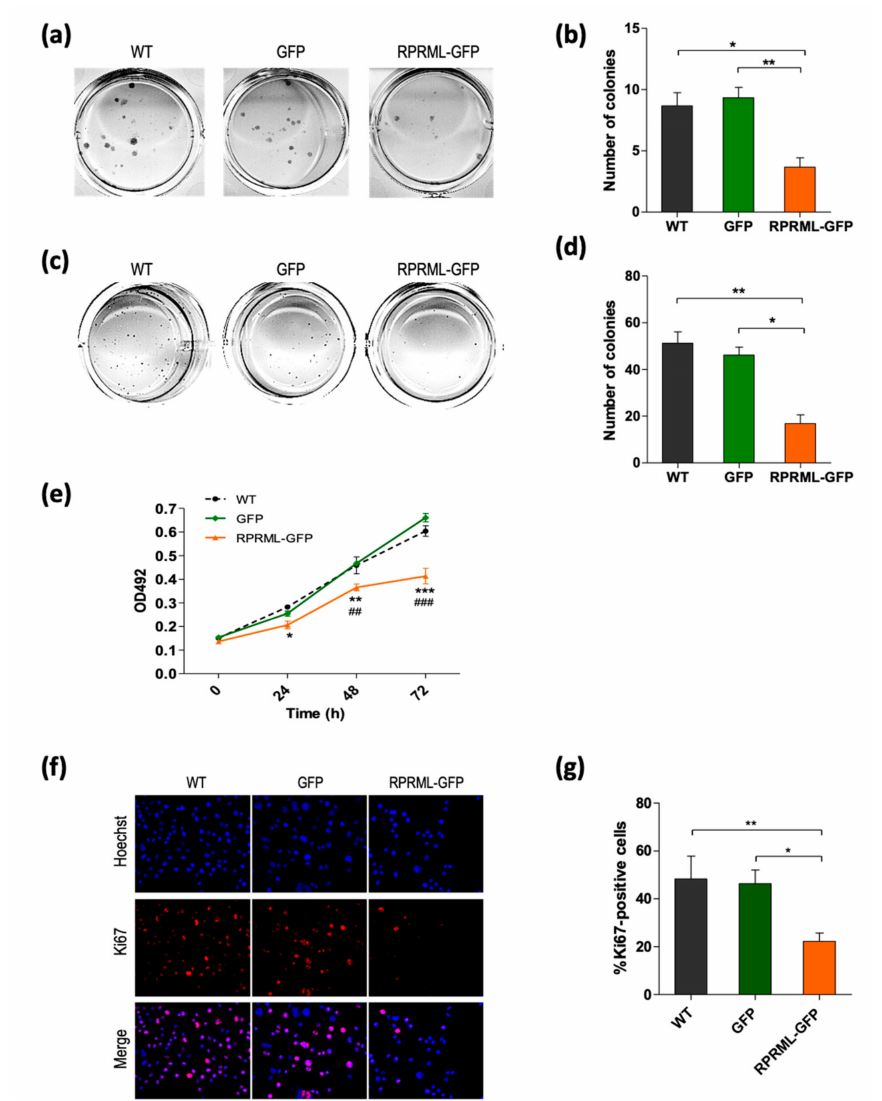
Figure 4. RPRML overexpression inhibits clonogenic capacity, anchorage-independent growth, and proliferation. ( a ) Representative image of a colony formation assay in wild type (WT), GFP-, and RPRML-GFP–overexpressing AGS cells. ( b ) Quantification of colony formation assay. The results are the mean number of colonies of three independent assays and the standard error of the mean (SEM) (bars). Statistical analysis: Kruskal-Wallis test ( p = 0.007) followed by Dunn’s multiple comparison test (** p < 0.01, * p < 0.05). ( c ) Representative images of soft agar colony formation assay in WT, GFP-, or RPRML-GFP–overexpressing cells. ( d ) Quantification of soft agar colony formation assay. Colonies > 50 µ m were counted. The results are the mean number of colonies of three independent assays and the SEM (bars). Statistical analysis: Kruskal-Wallis test ( p = 0.001) followed by Dunn’s multiple comparison test (** p < 0.01, * p < 0.05). ( e ) Cell proliferation of WT, GFP-, and RPRML-GFP–expressing AGS cells was evaluated by MTS assay at 0 h, 24 h, 48 h, and 72 h ( n = 3). Di ff erences at each time point were evaluated by two-way repeated-measures ANOVA and a post hoc Bonferroni test. * WT vs. RPRML-GFP, # GFP vs. RPRML-GFP. p < 0.05 (*), p < 0.01 (**, ## ), p < 0.0001 (***, ### ). ( f ) Representative images of Ki67 immunofluorescence (red) and Hoechst staining (blue) in WT, GFP-, and RPRML-GFP–overexpressing AGS cells. ( g ) Percentage of Ki67-positive cells. Five random fields at × 10 magnification were quantified using ImageJ. Results represent the means of three independent experiments; bars indicate SEM. Di ff erences between conditions were analyzed using the Kruskal-Wallis test followed by Dunn’s multiple comparison test (** p < 0.01, * p <